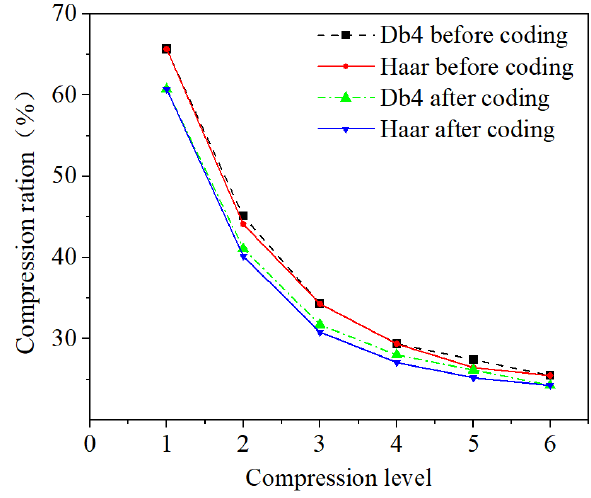
Figure 10. Plot of the multiscale wavelet decomposition under different series. Table 3. The measured gas data reconstruction effect (ERR).